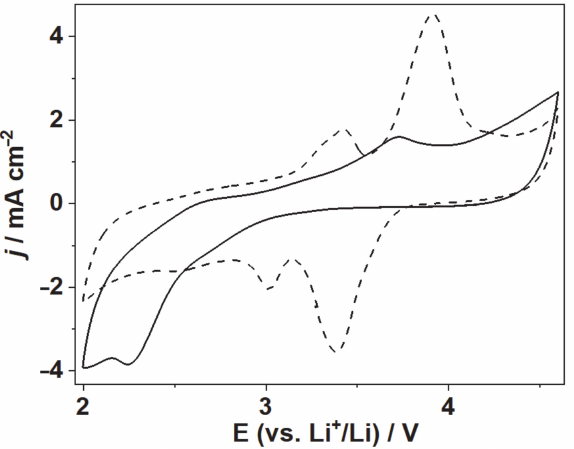
Figure 7. Cyclic voltammetry performed at 0.02 V s − 1 for 1 M lithium bis-(trifluoromethanesulfonyl)- imide (LiTFSI), Triglyme solution in argon atmosphere (dotted line) and in oxygenated cell (continu- ous